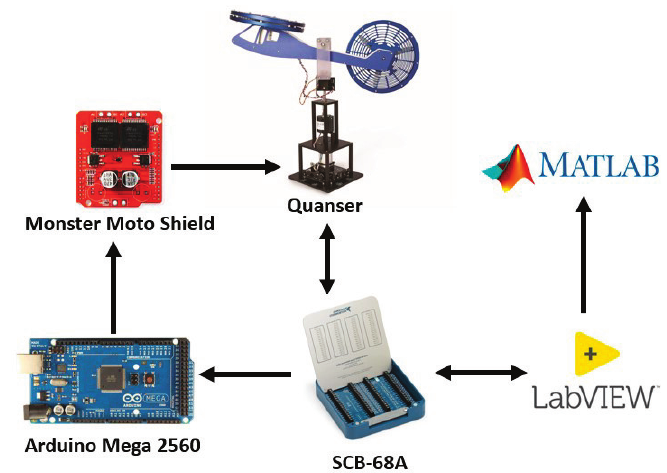
Figure 5. Actual picture of the 2-DOF helicopter.